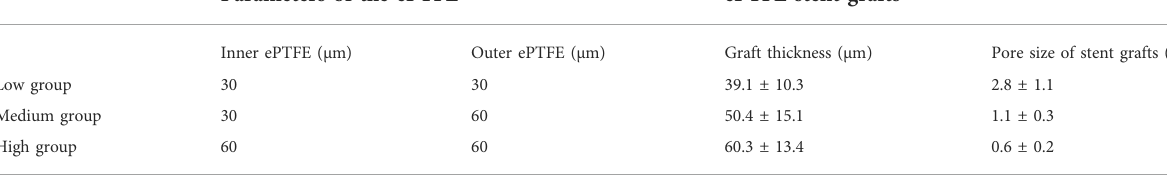
TABLE 1 The ePTFE thickness and the pore size of the low, medium, and high groups. Parameters of the